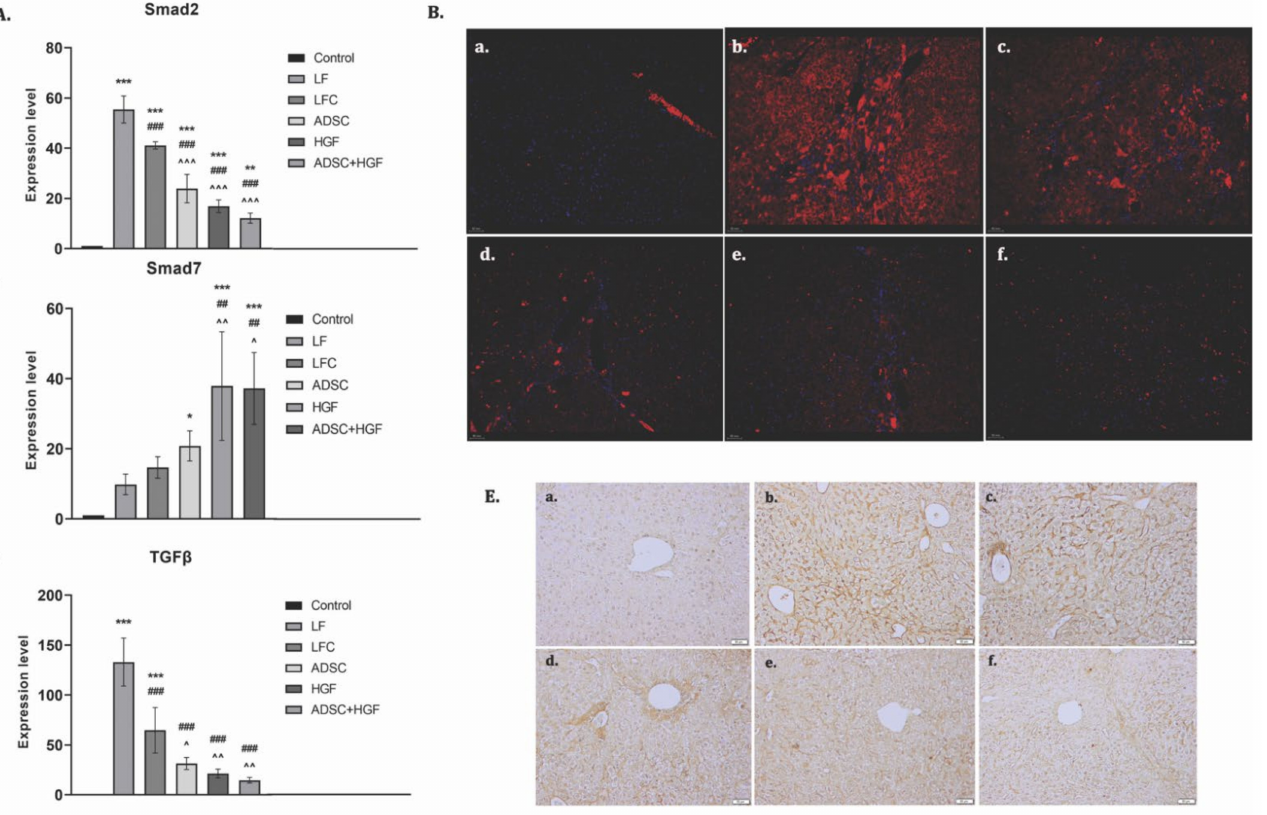
Figure 8. ADSC and HGF cotreatment inhibit profibrotic TGF- β 1/Smad signaling. Legend: Control, LF group—liver fibrosis in diabetic mice; LFC group—self-recovery of liver fibrosis (positive